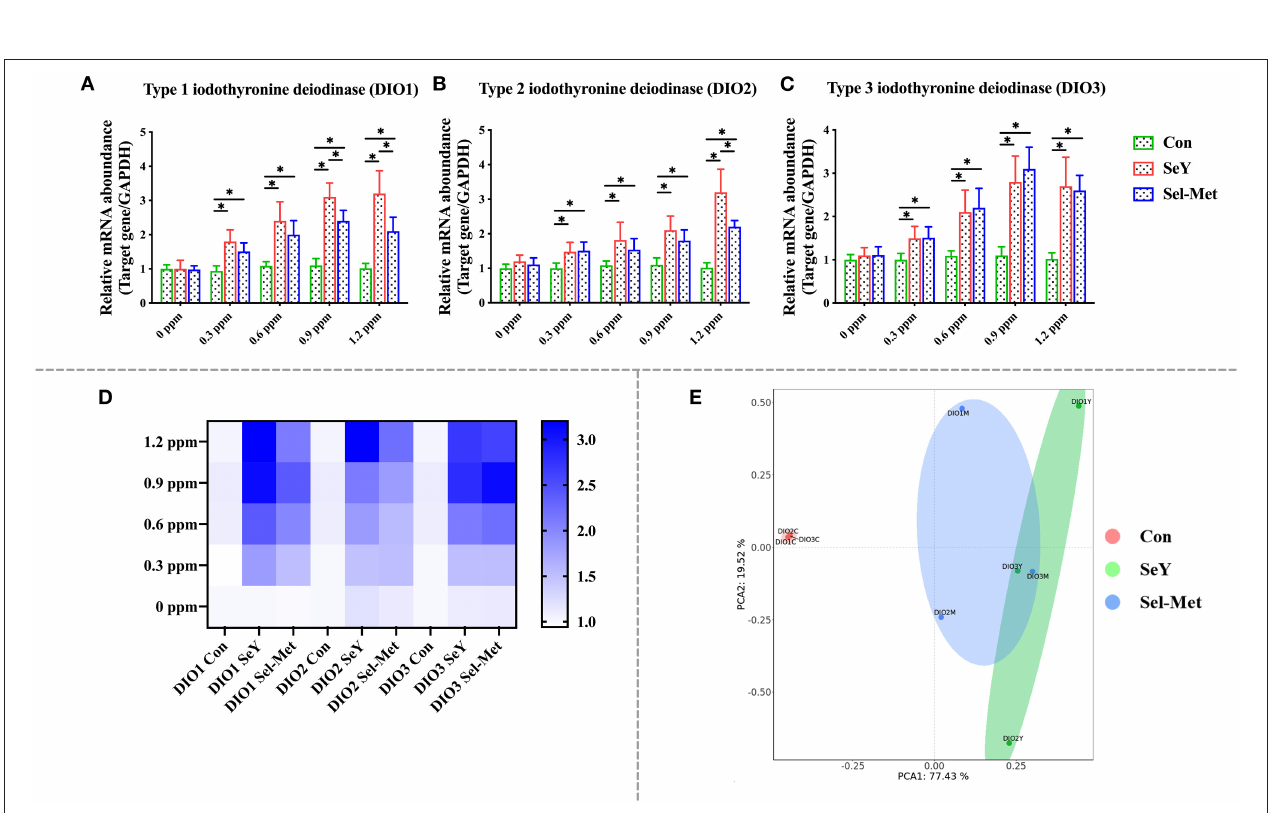
FIGURE 2 | Supplement SeY and Sel-Met to mRNA expression of DIOs family in PMECs. The cells were incubated with SeY and Sel-Met at different concentrations (0, 0.3, 0.6, 0.9, and 1.2 ppm) for 24h, respectively, and then collected to detect mRNA expression. Data were expressed as mean ± SEM ( n = 6), and different superscripts * indicate statistically significant differences ( P < 0.05). (A–C) Are the mRNA expression level of DIOs detected by qPCR. (D) Heat map comparison of DIOs mRNA levels. (E) PCA score plot results compared the mRNA expression of the DIOs family among the three